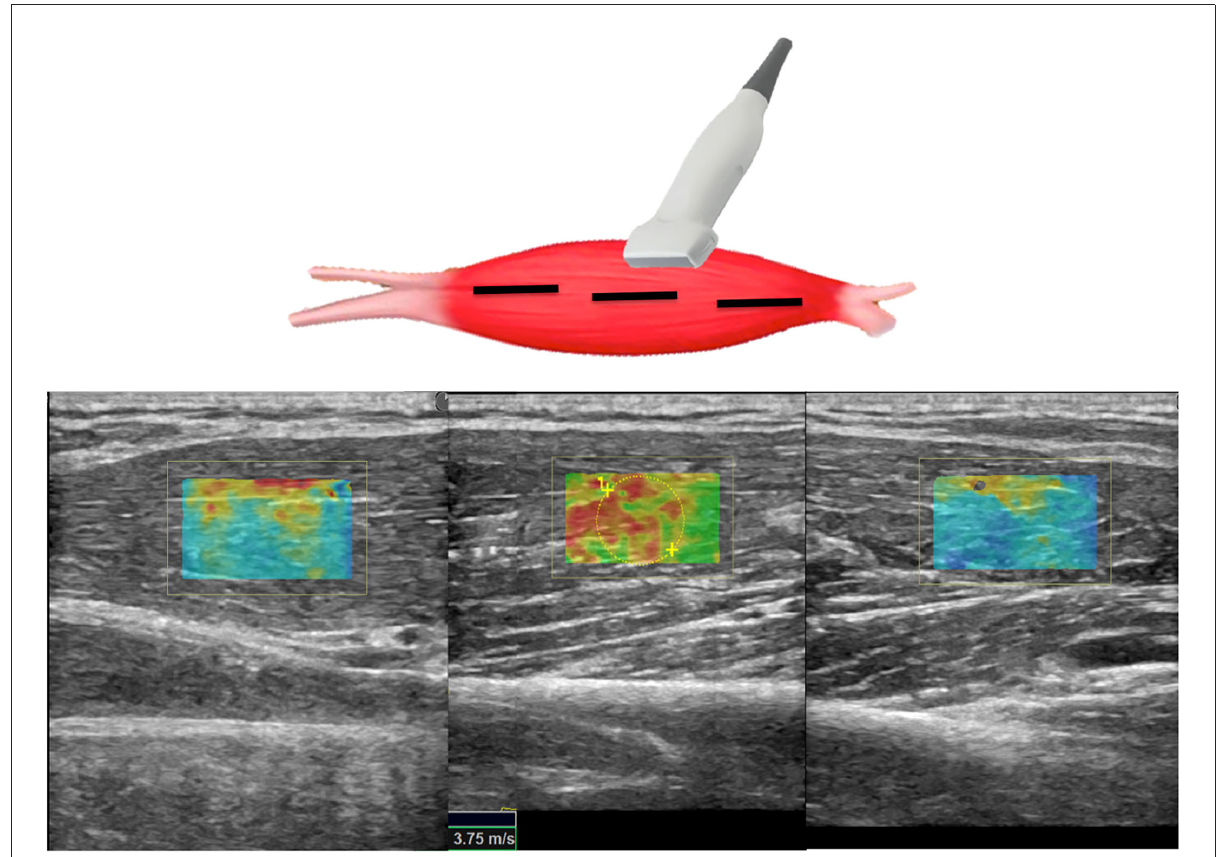
FIGURE2 Scheme illustrating SWE acquisition on the long axis of muscular fibers: the transducer is placed on the muscle belly performing consecutive longitudinal scans to assess the maximum amount of muscle; in each scan, SW velocities are measured in the positioned rectangular ROI generating the relative color-coded elastogram superimposed to the B-mode image (below). The stiffness at any location within the ROI is sampled using the measurement tool (dotted circles). A final median value is then expressed.